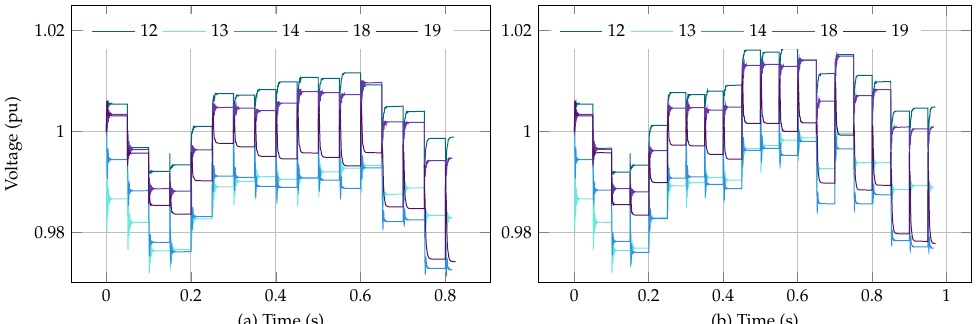
Figure 7. Voltage dynamics at each converter for load case 1. ( a ) Constant load model. ( b ) Frequency- dependent load model.